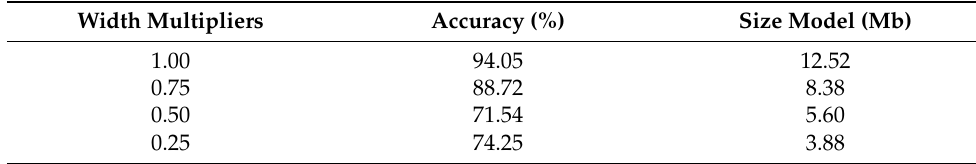
Table 2. Performance of MobileNets on different width multipliers (fixed resolution = 224). Width